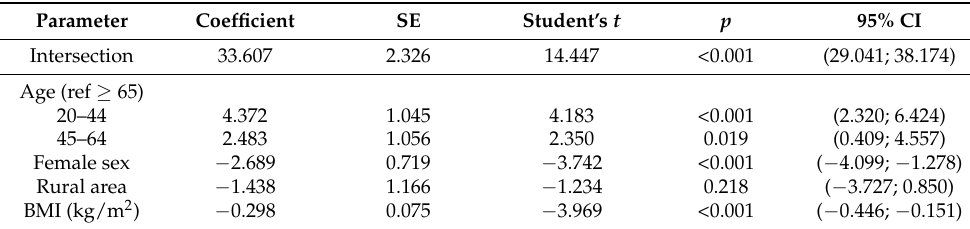
Table 3. General linear model for VitD level concerning the demographic factors considered.